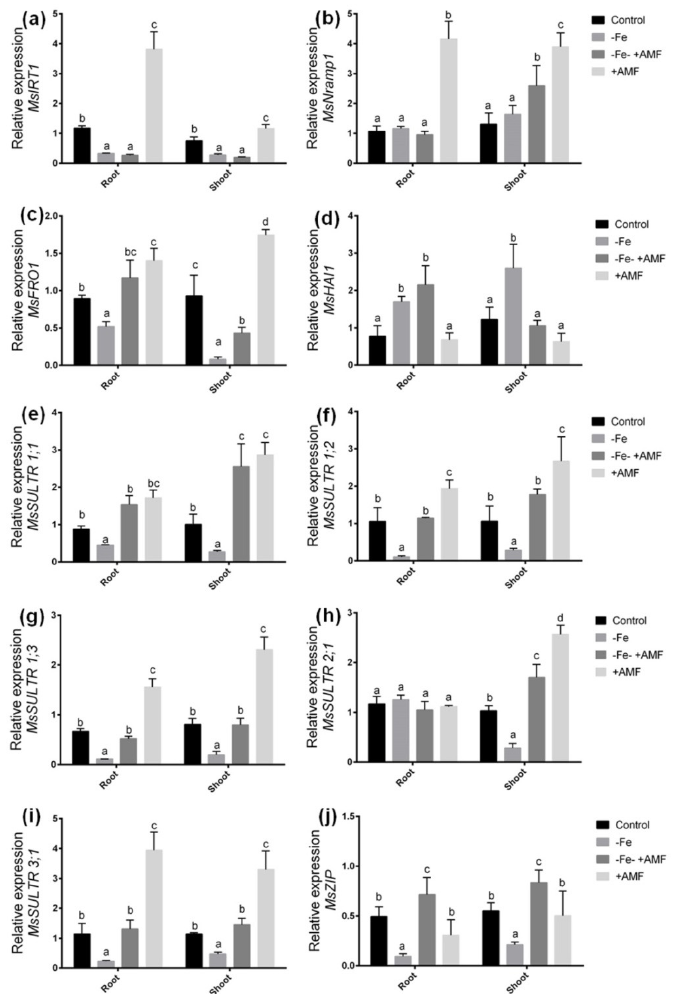
Figure 5. Quantitative expressions of candidate genes in alfalfa root and shoot in response to Fe deficiency with or without AMF. ( a ) Response of MsIRT1 , ( b ) MsNramp1 , ( c ) MsFRO1 , ( d ) MsHAI1 , ( e ) MsSULTR1;1 , ( f ) MsSULTR1;2 , ( g ) MsSULTR1;3 , ( h ) MsSULTR2;1 , ( i ) MsSULTR 3;1 , and ( j ) MsZIP genes. The level of relative gene expression was analyzed using the dd −∆ Ct method, and MsActin was used as internal control. Data represent means ±SD ( n = 3). Different letters above the error bar indicate significant difference at p < 0.05 level.